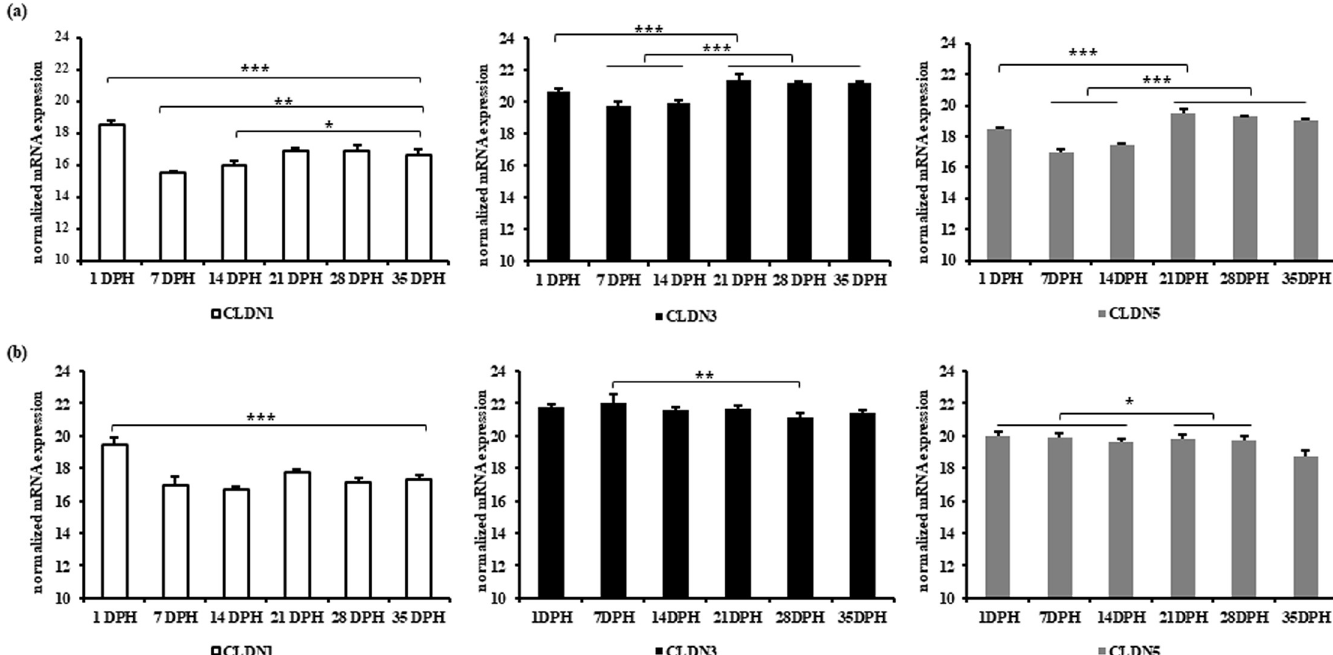
Fig 5. Normalized mRNA expression of barrier-forming claudins in (a) jejunum and (b) caecum at different age of broiler chickens. Results are presented as means with SEM (n = 5 birds). Statistical analysis was performed using ANOVA and Duncan’s test, � = P � 0.05, �� = P � 0.01, ��� = P � 0.001. Horizontal lines above the bars indicate no